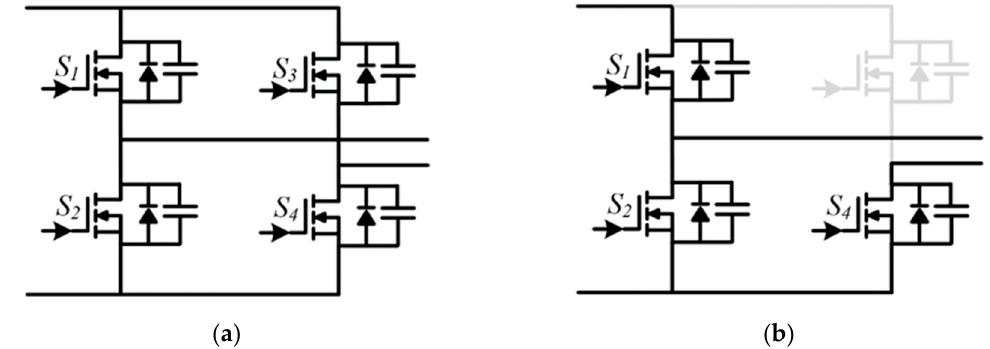
Figure7. Modulationoffull-andhalf-bridge: ( a )full-bridgemodulationand( b )half-bridgemodulation. Figure 7. Modulation of full - and half-bridge: ( a ) full-bridge modulation and ( b ) half-bridge modulation.